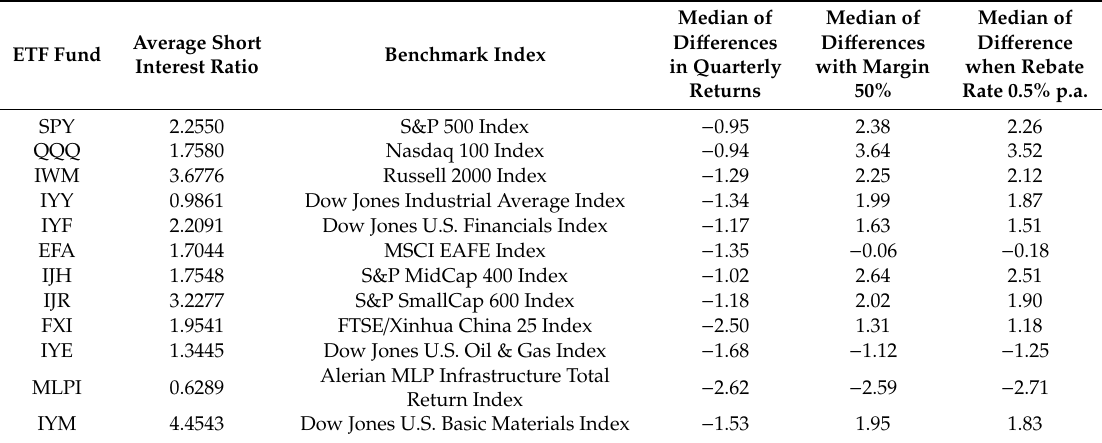
Table 3. Average short interest ratio of ETFs, their benchmark indexes and median of di ff erences in quarterly returns between ETFs and inverse ETFs in the period 2011–2017.